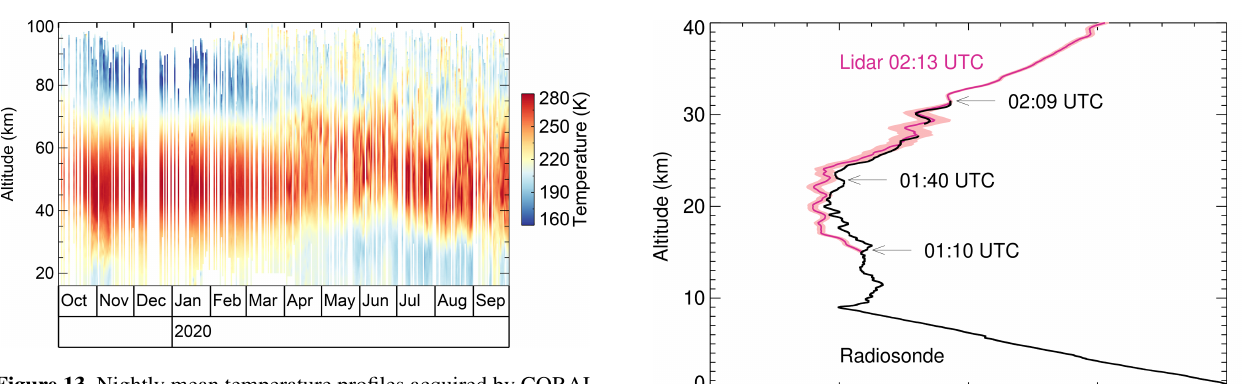
Figure 13. Nightly mean temperature profiles acquired by CORAL over a 12-month period in 2019 and 2020.